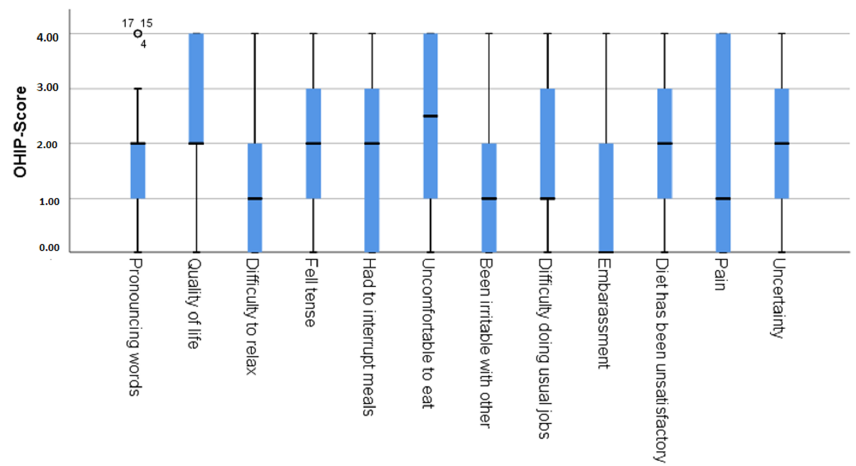
Figure 2. Box plot of the OHIP-14G item values. Table 4. Total 14-item Oral Health Impact Profile (OHIP-14G) values per item given by the par- ticipants (expressed as percentages), where 0 = never; 1 = hardly ever; 2 = occasionally; 3 = often; 4 = very often. The results were obtained from each question of the OHIP-14G